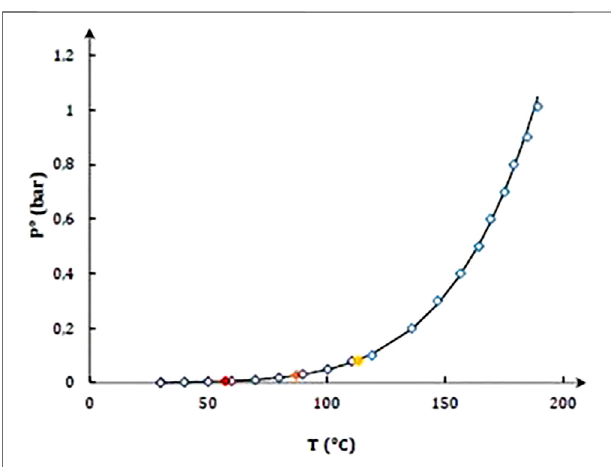
FIGURE3 | BG vapor pressure reported byCrosby and Berthold (1960) ( ), reported by Forman et al. (1941) ( ), measured in FISCHER ® LABODEST ® VLE 602 ( ), measured in LMI ( ◊ ), and calculated